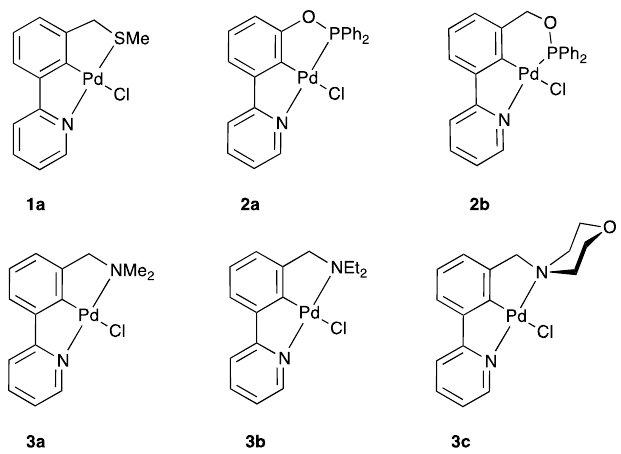
Figure 1. Unsymmetrical pincer palladacylces, SCN ( 1a ) [13], PCN ( 2a – 2b ), and N’CN ( 3a – 3c ) [14].